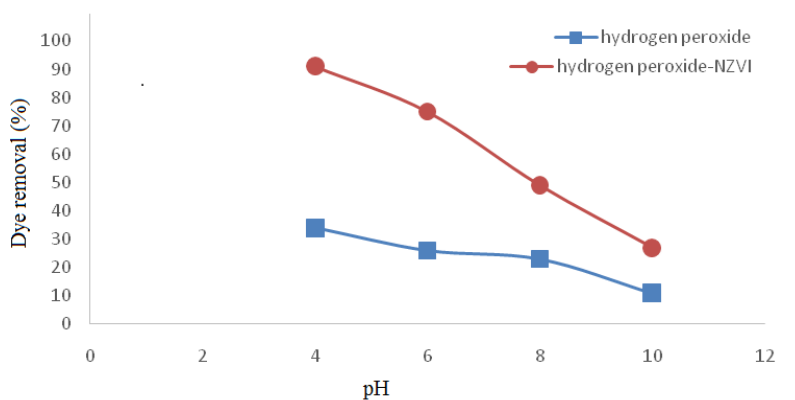
Fig 4. Effect of pH on process efficiency. (Dye concentration: 75 mg/L, contact time: 40 min, concentration of nanoparticles: 2 g/L, concentration of hydrogen peroxide 200 Mmol).